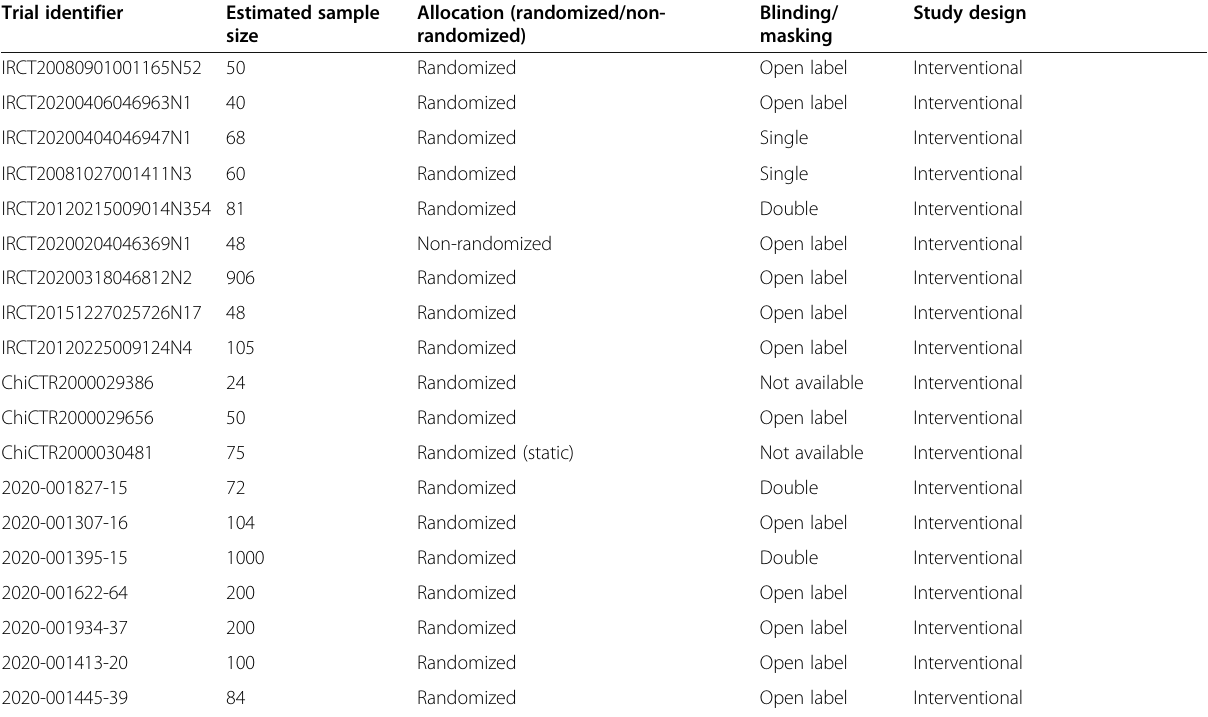
Table 2 Methodological quality of included trials (Continued) Trial